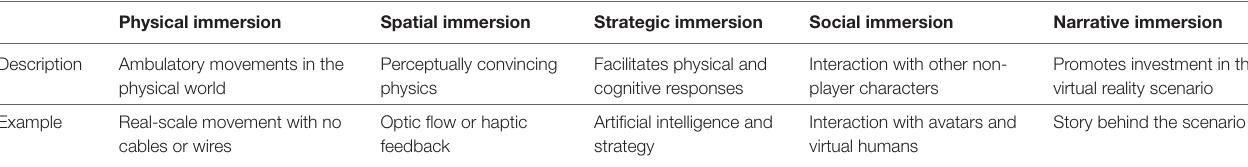
tAbLe 1 | Examples of essential criteria for a fully immersive virtual environment training